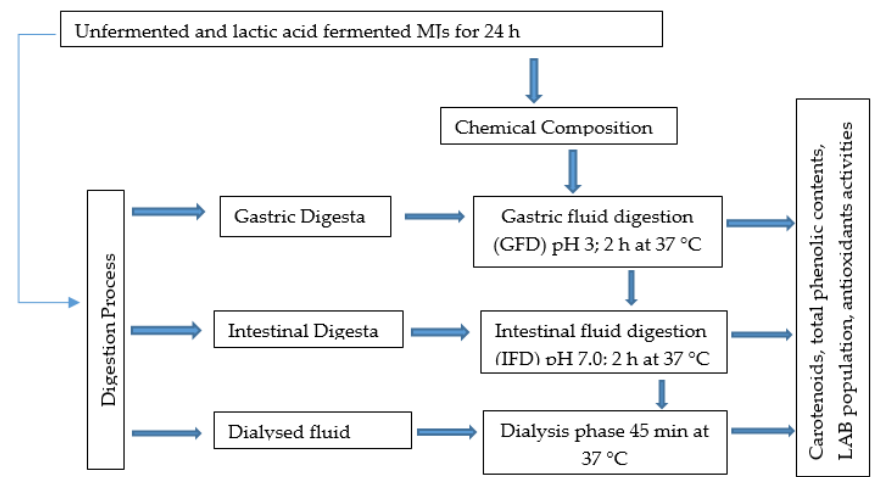
Figure 1. Schematic diagram of simulated in vitro GI digestion of unfermented and fermented MJs incubated for 24 h at 37 °C.